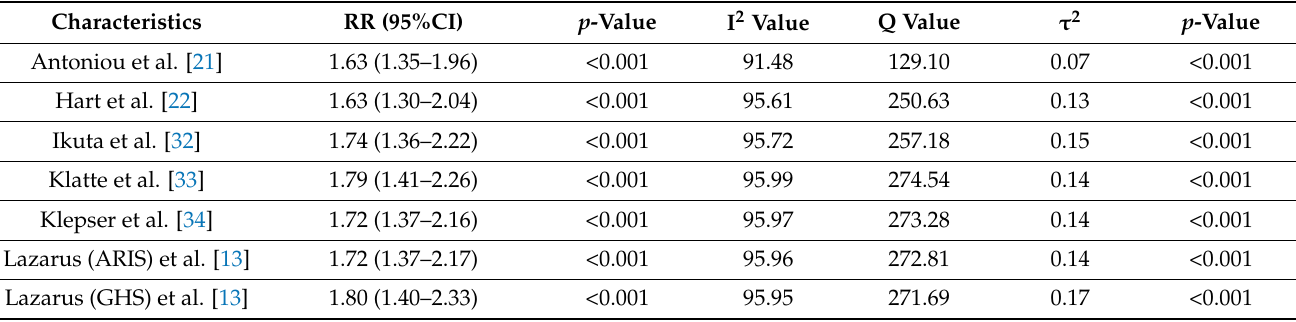
Table 3. Sensitivity analysis of PPI use and the risk of acute kidney